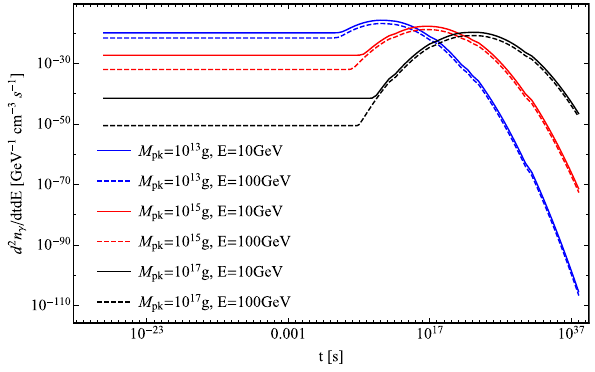
Fig. 1 The spectrum d 2 n γ / d t d E of a PBH bubble as a function of cosmic time t for peak masses M pk = 10 13 , 10 15 , 10 17 g and photon energies E = 10 , 10 amma − raysi 0 GeV, respectively. For simplicity, we have set ˜ f PBH = 1 and σ = 1